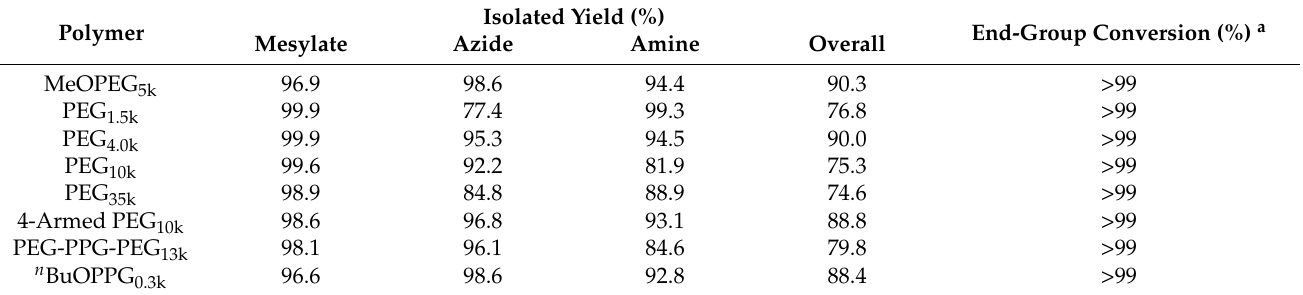
Table 1. Isolated yield and end-group conversion of the functionalized